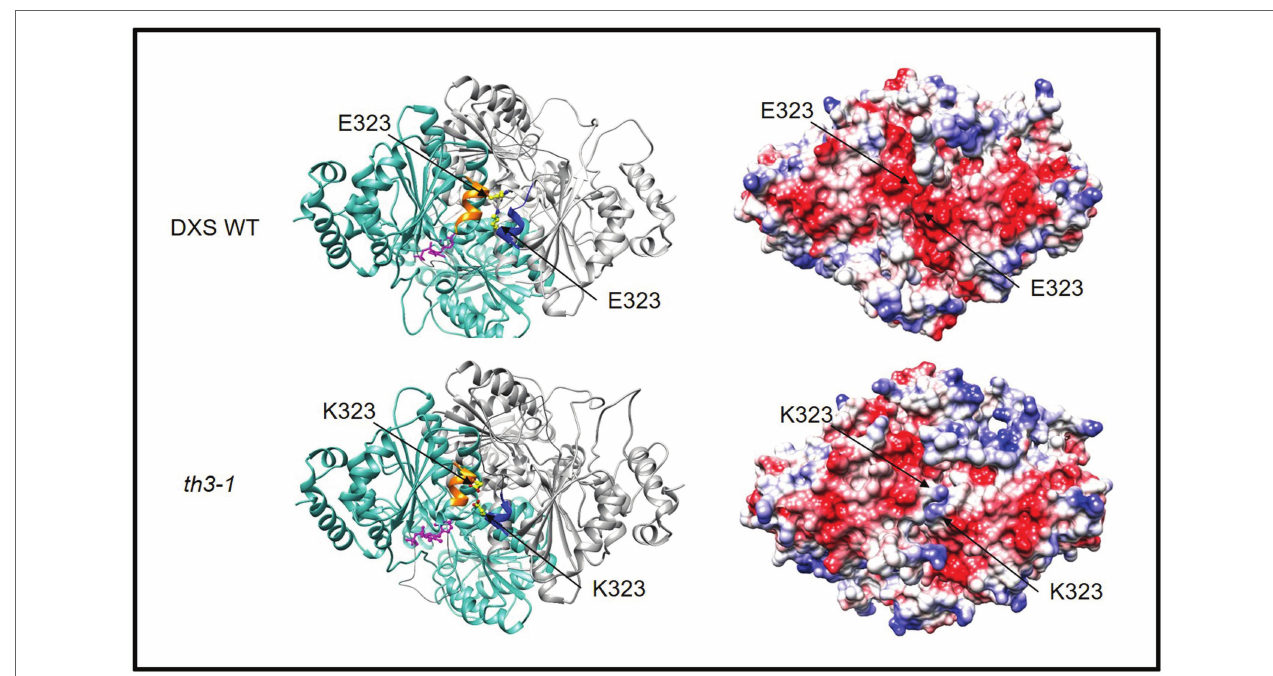
FIGURE 4 | The th3 E323K mutation occurs at interface of DXS subunits. Glutamate 323 occurs in a short α -helix (gold and blue) that aligns at the interface of the DXS homodimer (ribbon formatted subunits colored light blue and gray, respectively). The lysine substitution alters the electrostatic surface charge of the DXS protein (right). Positive surface charge is colored blue, and negative surface charge is red. Structural models of WT and mutant protein were constructed by homology to DXS of D. radiodurans (PDB:6ouw, Chen et al., 2019) using MODELER (Webb and Sali, 2016). Disordered segments adjacent to the conserved α -helix were not included in the model. Graphics were made using the UCSF Chimera (Pettersen et al.,